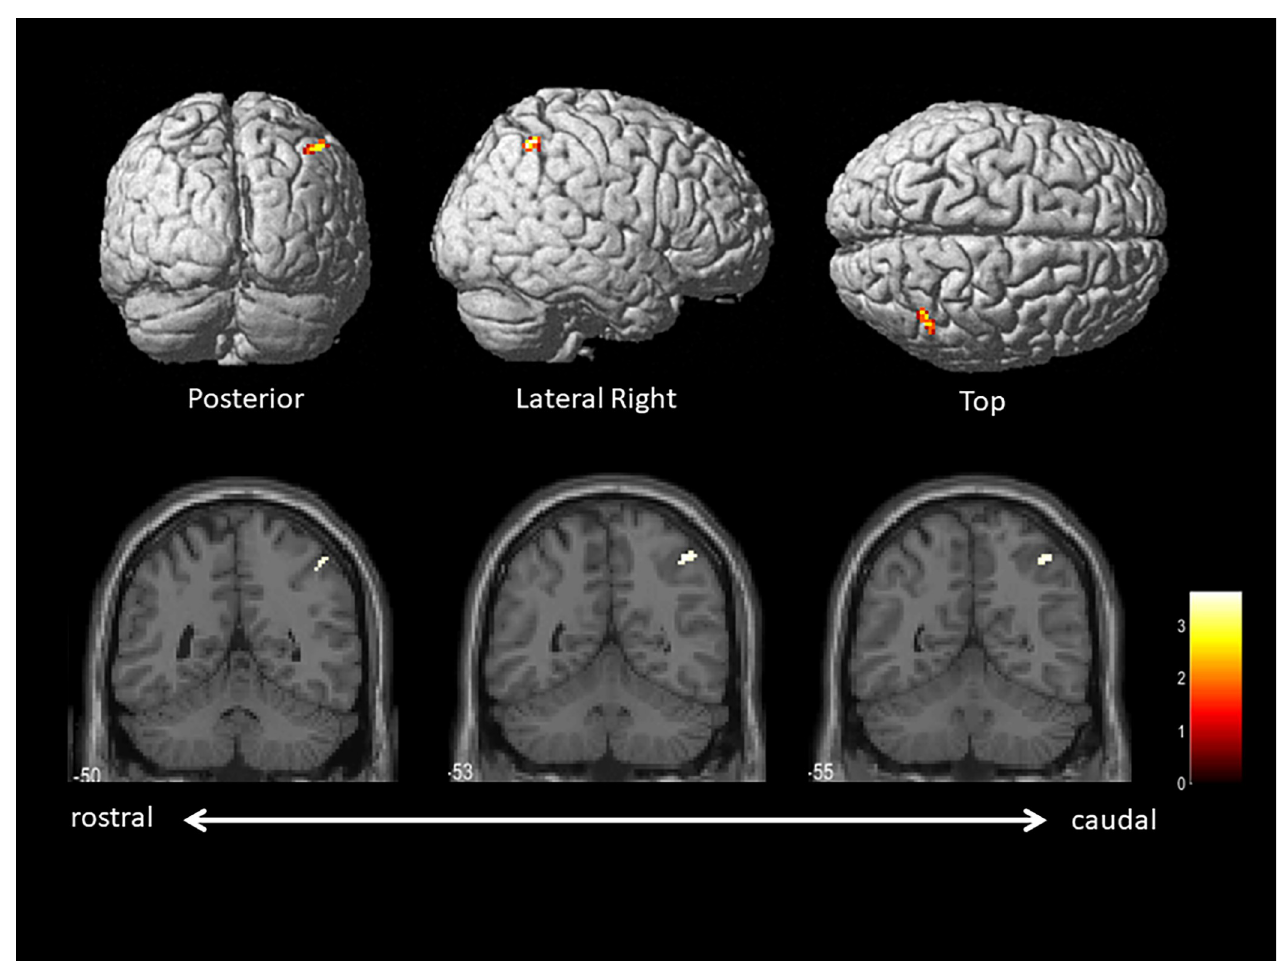
Fig 2. Brain regions in which the resting CMRglc was negatively correlated with the number of left–right reversed characters. The statistical threshold was set at an uncorrected p < 0.001 at the voxel level and 20 voxels at the cluster level. Additional covariates were age, sex, levodopa equivalent daily dose, Unified Parkinson’s Disease Rating Scale Part III score, Mini–Mental State Examination score, forward and backward digit span, and forward and backward tapping spans. The results were overlaid on rendered brain (top row) or T1 single-subject template (bottom row) from SMP 12. found an association between reading left–right reversed strings of letters and the intraparietal sulcus. In addition, Dong, Fukuyama, Honda, Okada, Hanakawa et al. [19] conducted a func- tional magnetic resonance imaging study of Japanese individuals who read left–right reversed strings of kana characters. This study showed that the activity of the area close to the medial wall of the intraparietal sulcus of the right superior parietal lobule was significantly correlated with behavioral performance. The findings of these functional imaging studies suggest that the right superior parietal cortex and intraparietal sulcus play important roles in the recognition of left-right reversed letters.